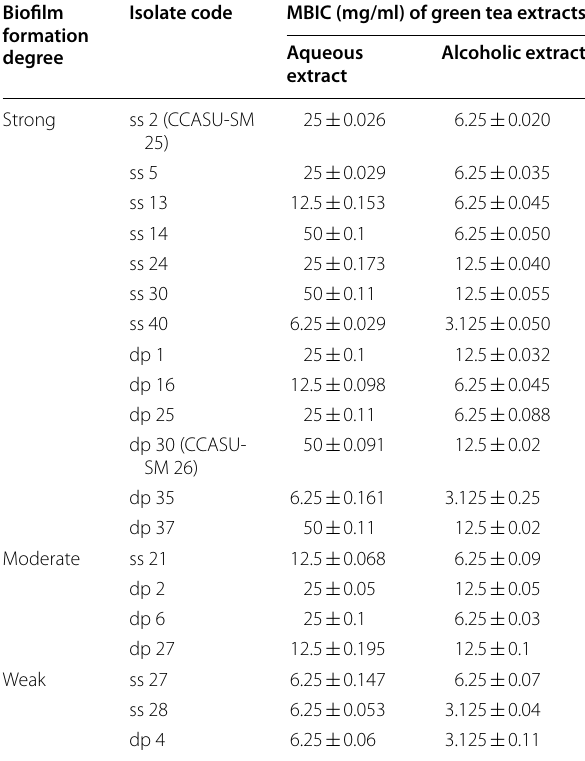
* The activity was expressed as minimum biofilm inhibitory concentration (MBIC)